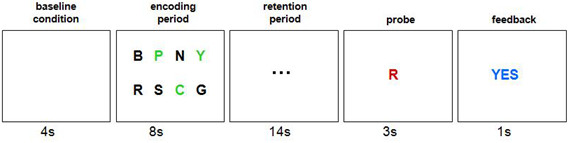
Working memory paradigm. Below each frame is the duration of each test block in seconds.